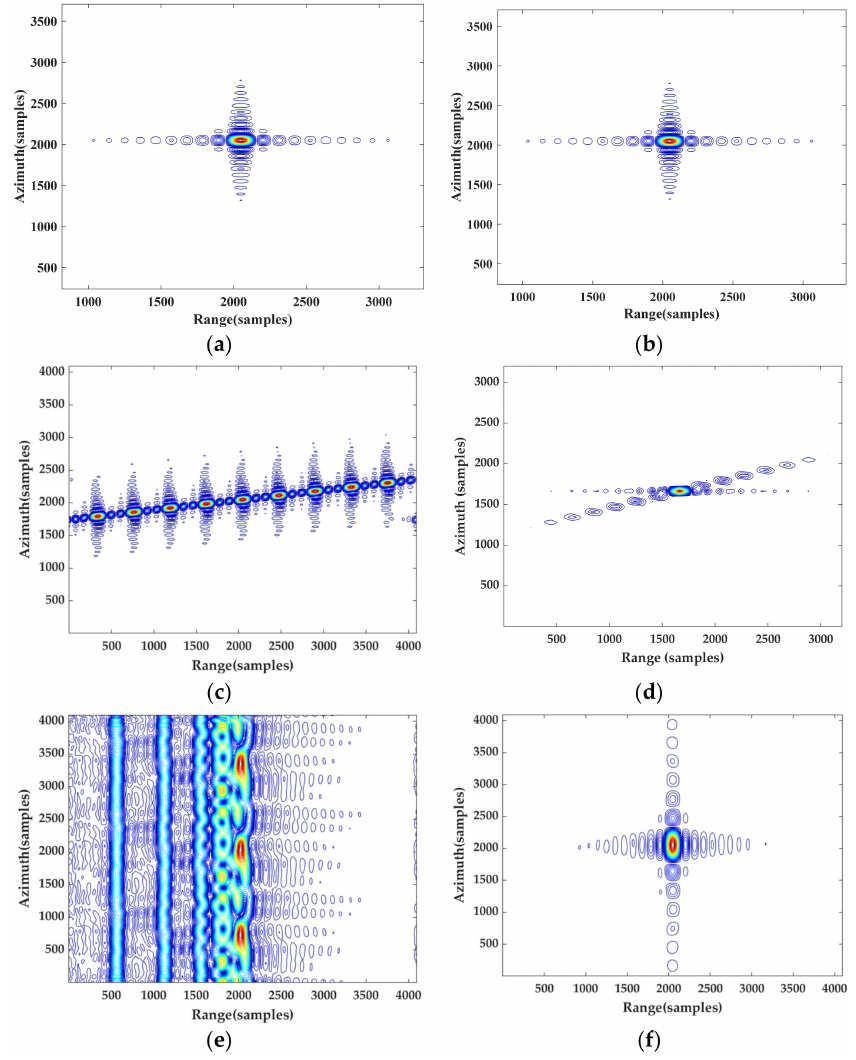
Figure 17. Imaging Results. ( a ) At perigee based on MESRM. ( b ) At perigee based on R4-ESRM. ( c ) At squint subduction section with MESRM. ( d ) At squint subduction section based on R4-ESRM. ( e ) At apogee based on MESRM. ( f ) At apogee based on